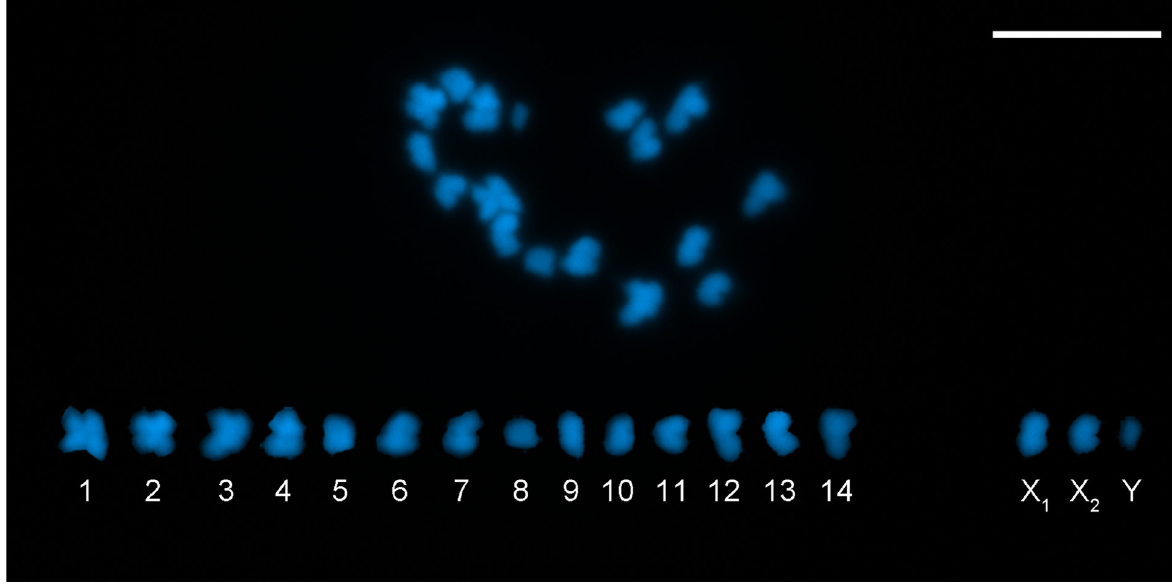
Figure 2. Male meiotic karyotype of Cyanolicimex patagonicus . 2n= 31= 28A+X are stained with DAPI. Bar= 10 µm.